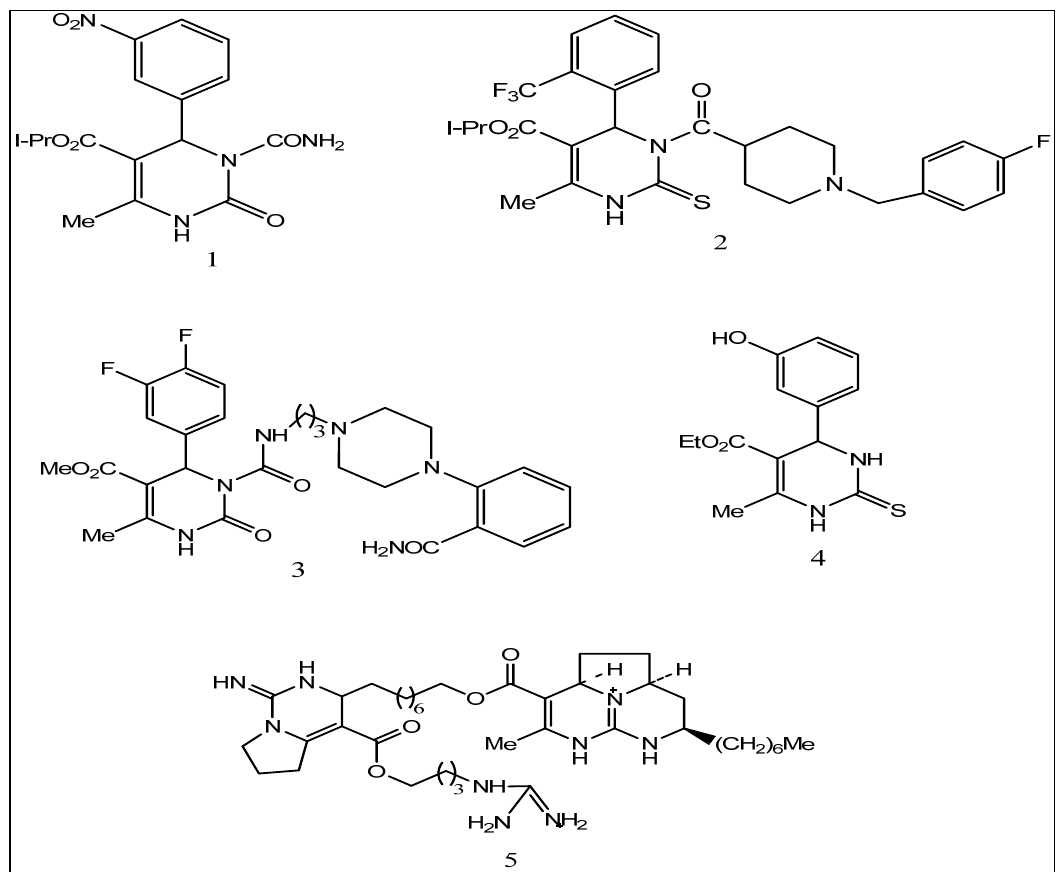
Figure 1. Reported derivatives of 3,4–dihydropyrimidin-2-( 1H )-Ones.